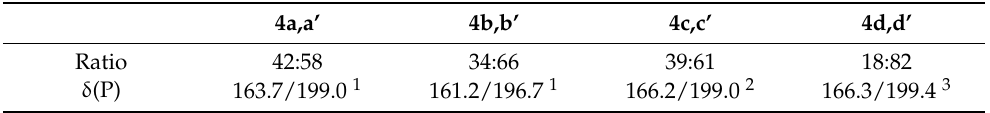
Table 2. 31 P{ 1 H}-NMR spectroscopic data of 4a,a’ – d,d’ , chemical shifts in ppm, coupling constants in Hz.